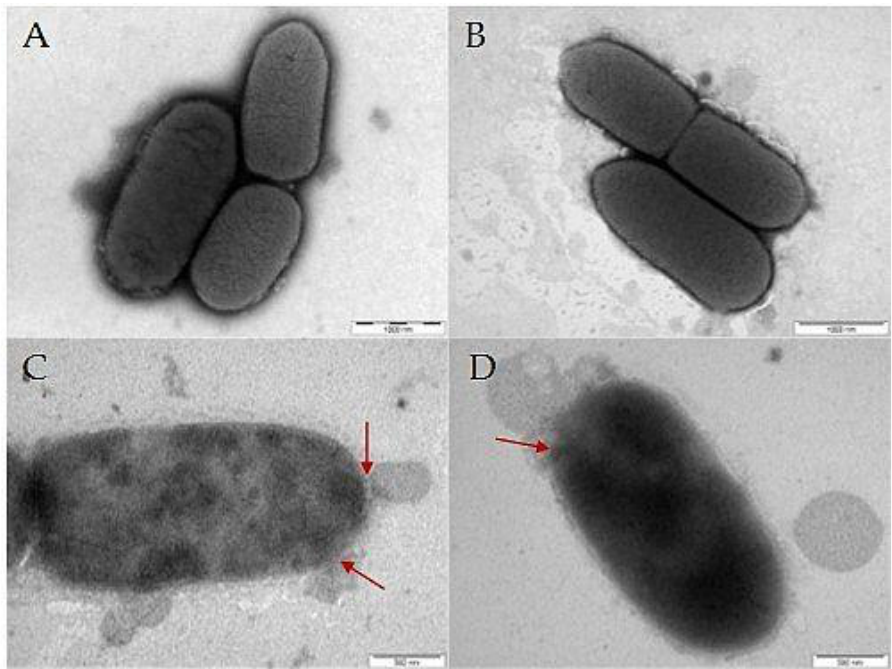
Figure 6. Images of E. coli cells obtained by TEM. Disruptions in the bacterial cell wall are high- lighted with a red arrow: ( A ) control untreated E. coli, ( B ) E. coli incubated with control polymer P, ( C ) E. coli incubated with PEP , and ( D ) E. coli incubated with P-PEP . PEP induced the rupture of the cellular membrane.